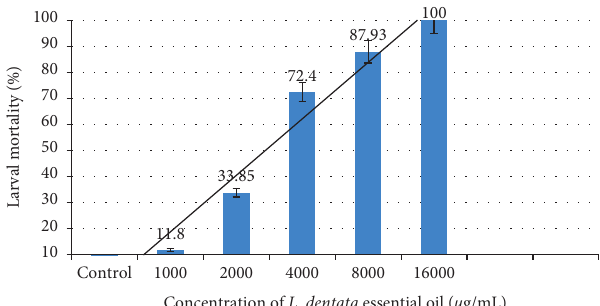
Figure 2: Mortality rate (%) of Culex pipiens larvae according to the concentrations of L. dentata spp. E. Oil after 24 h of treatment. Table 2: Lethal concentrations (LC 50 and LC 90 ) of L. angustifolia subsp. E. Oils and L. dentata spp. E. Oils. Plant species